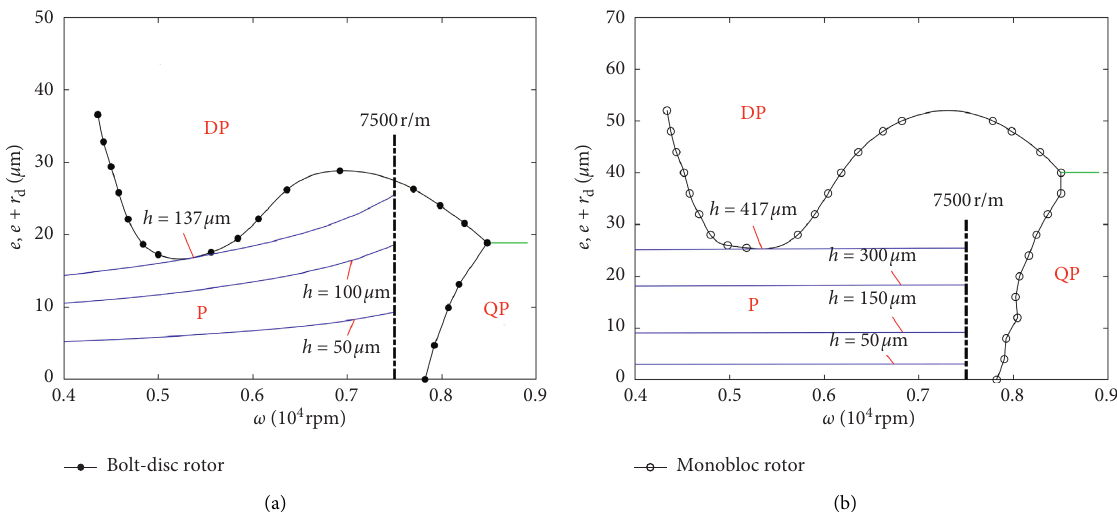
Figure 12: Allowable position error for both rotors: (a) allowable position error for bolt-disc rotor and (b) allowable position error for monobloc